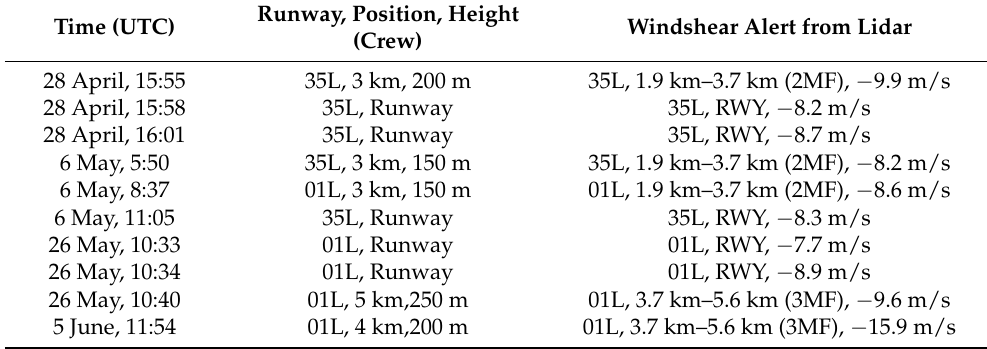
Table 3. Windshear event reports from